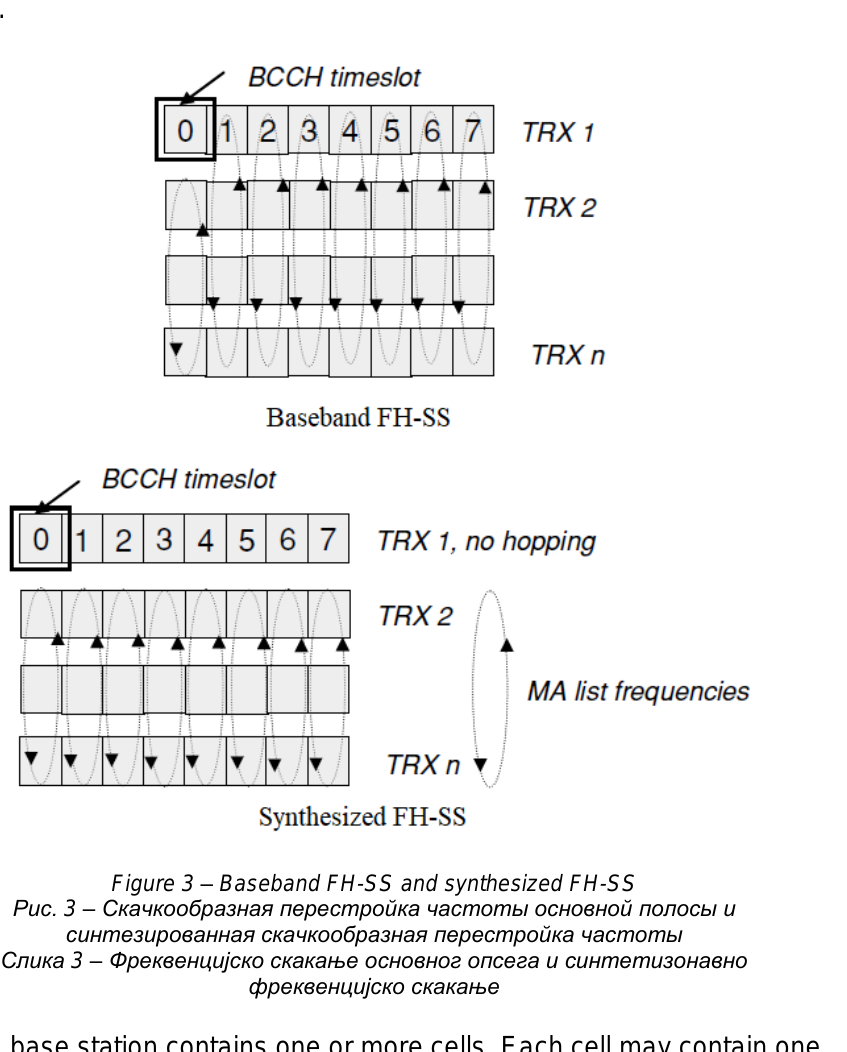
Figure 3 – Baseband FH-SS and synthesized